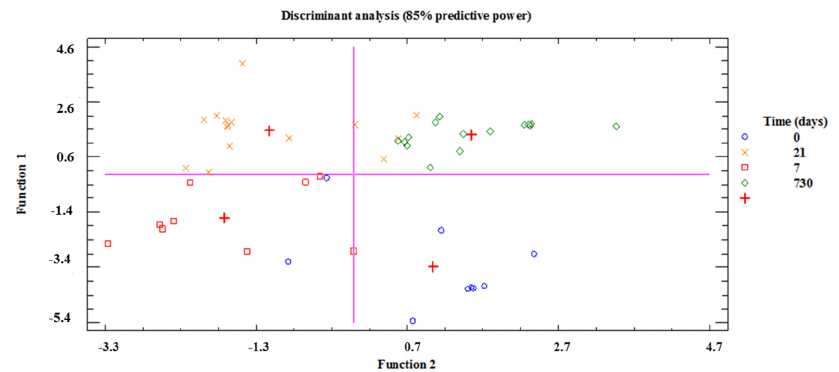
Figure 6. Multiple discriminant analysis (MDA) of the immune data. MDA was applied to the immunological data of meconium (blue circles), first week (red squares), third week (orange cross), and 2 ‐ year (green rhombus) feces, taking sampling time as the discriminant factor. The red cross represents the mathematical centroid for each sampling time group (meconium, first week, third week, and 2 ‐ year fecal samples). The first and second functions, which were plotted as the x and y axes, had a predictive power of 85% and internal axes (pink lines) match the zero values for both functions.